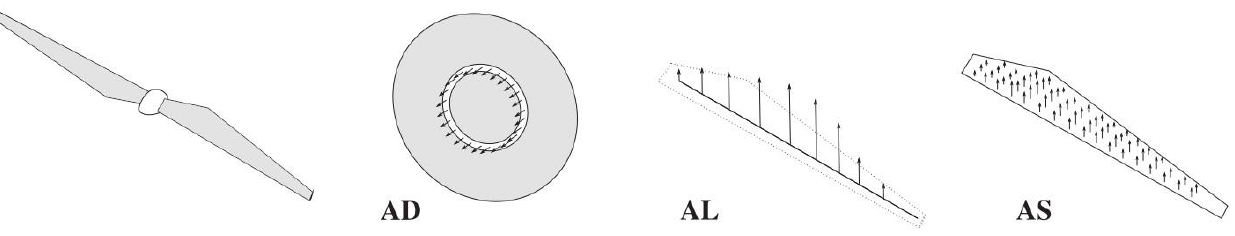
Figure 2. Three actuator models for wind turbine aerodynamics: AD, AL and AS [21].